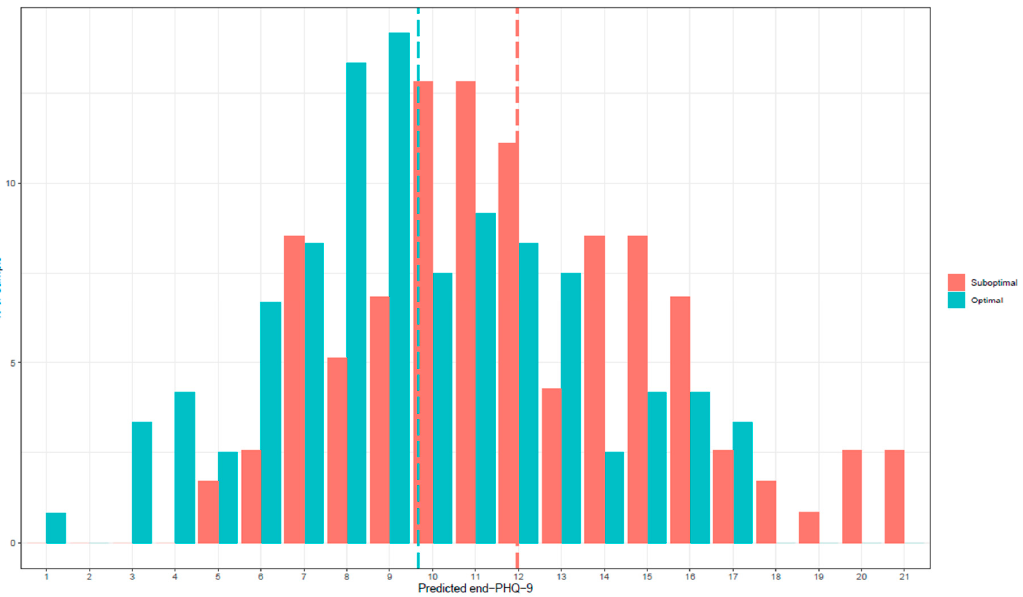
Figure 1. Frequency of predicted PHQ ‐ 9 scores at 12 weeks.